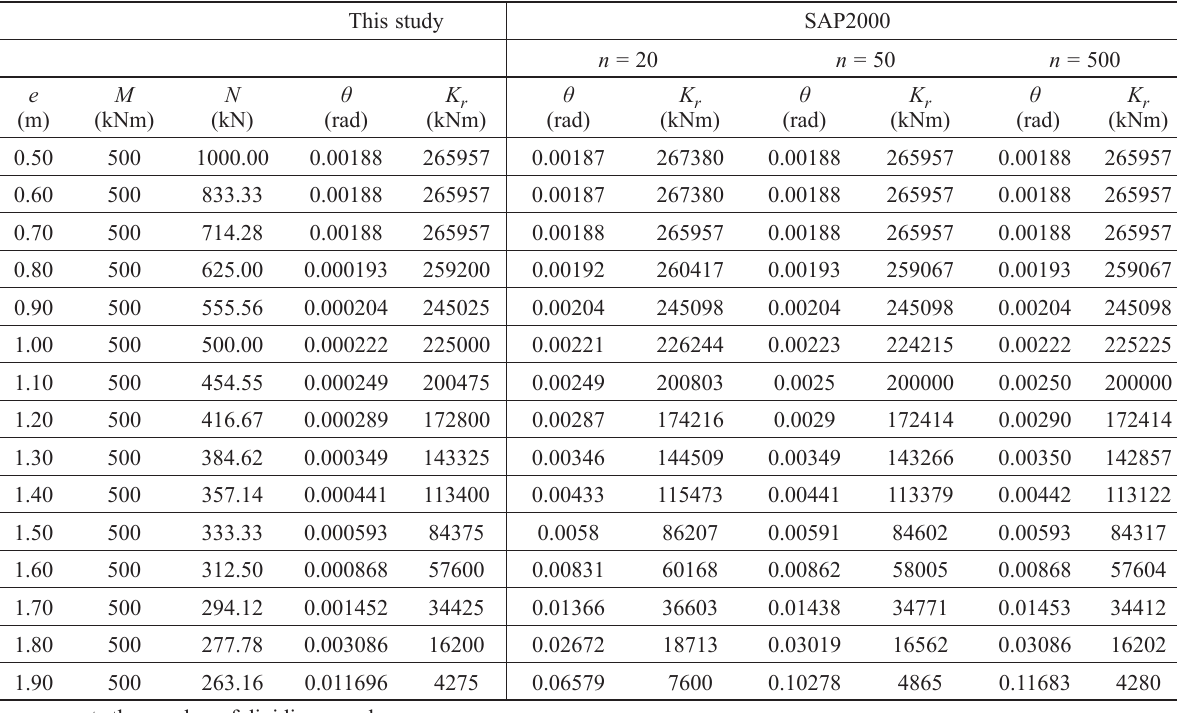
Table 2. Rotational spring constants of rectangular footing